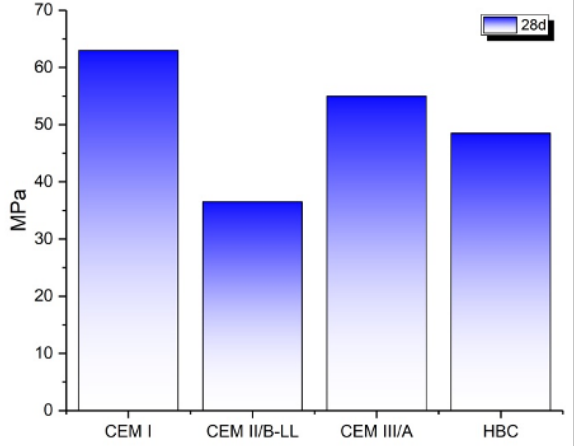
Figure 2. Compressive strength of the C1 concretes after 28 days of curing.